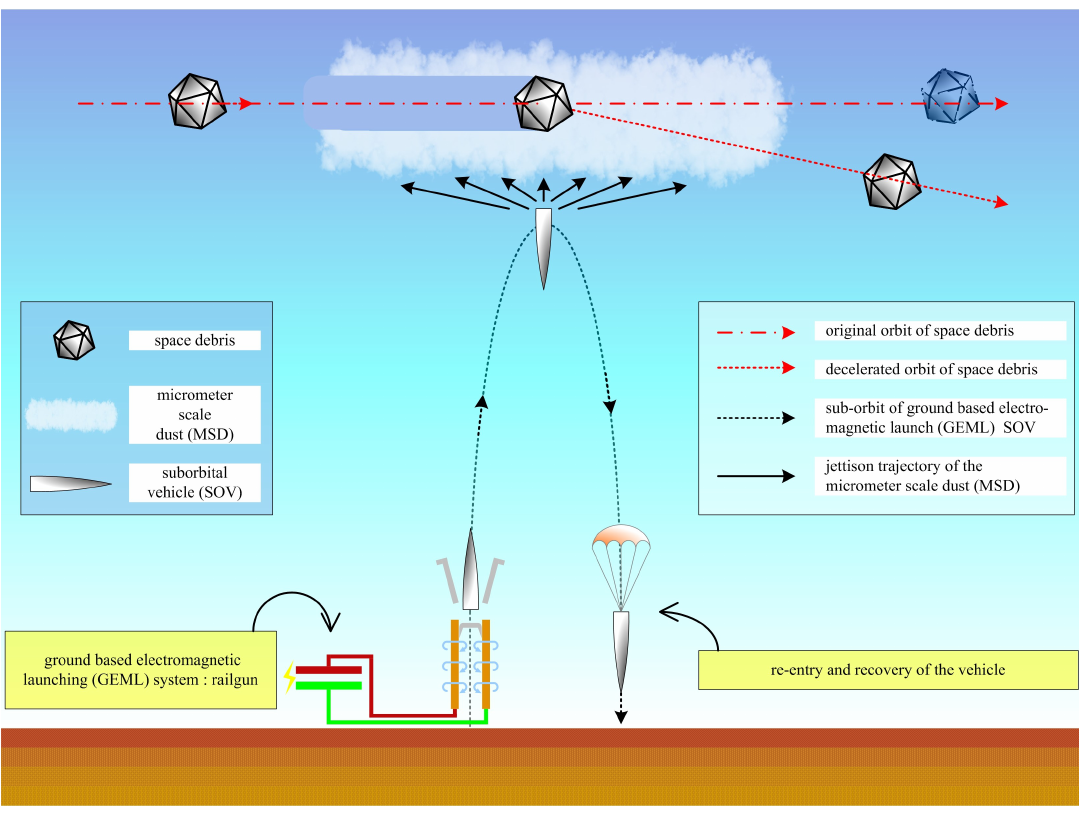
Figure 4. Schematic of DREL: System architecture and operating mechanisms